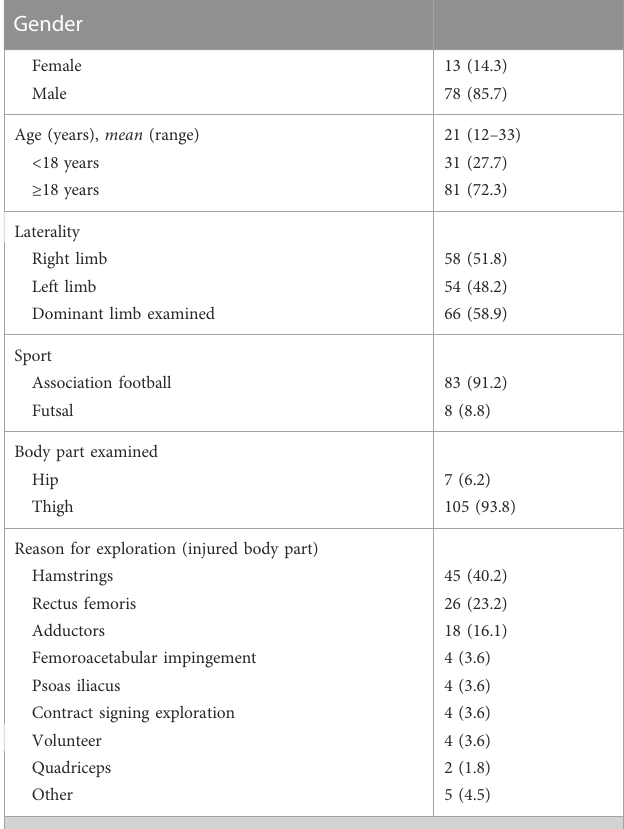
TABLE 1 Baseline demographic and epidemiological data of the studied